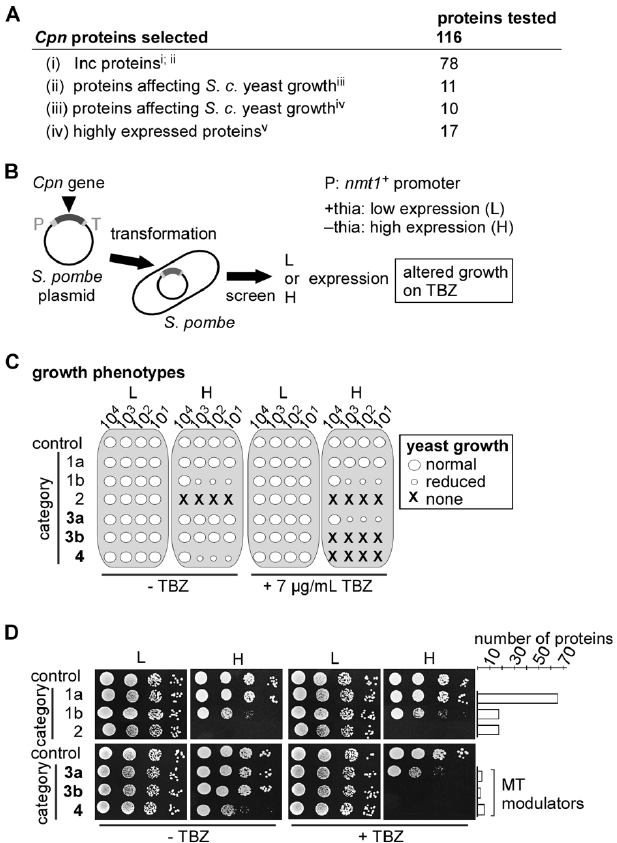
Figure 2. Identi fi cation of Cpn MT-modulating proteins via fi ssion yeast. ( A ) The 116 Cpn proteins Figure 2. Identification of Cpn MT-modulating proteins via fission yeast. ( A ) The 116 Cpn proteins chosen for the analysis were selected from Inc proteins (i, [39] ; ii, [45] ), proteins that a ff ect S. cere- chosen for the analysis were selected from Inc proteins (i, [39]; ii, [45]), proteins that affect S. cerevisiae visiae yeast growth (iii, [46] ; iv, [47] ) or those that are highly expressed in a transcriptome analysis yeast growth (iii, [46]; iv, [47]) or those that are highly expressed in a transcriptome analysis (v, [48]). ( B ) Schematic representation of the screen setup. Each Cpn gene (dark grey) was cloned into an S. pombe plasmid flanked by the thiamine-repressible S. pombe nmt1 + promoter (P) and nmt1 + terminator (T). S. pombe wild-type cells transformed with such a plasmid were tested for growth defects in